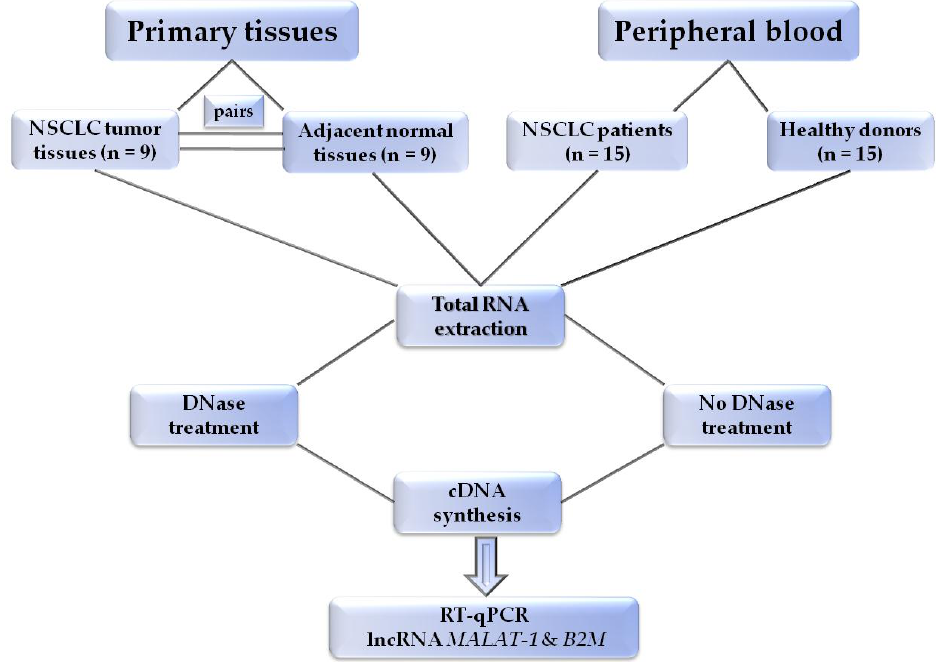
Figure 3. Outline of the experimental procedure.